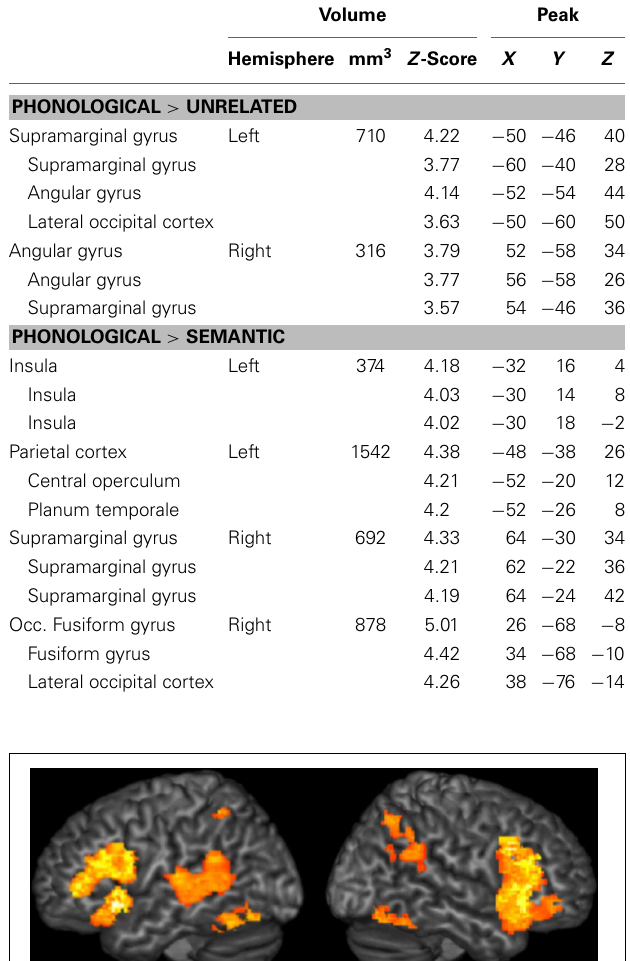
Table 3 | Phonological comparisons—areas of activation with